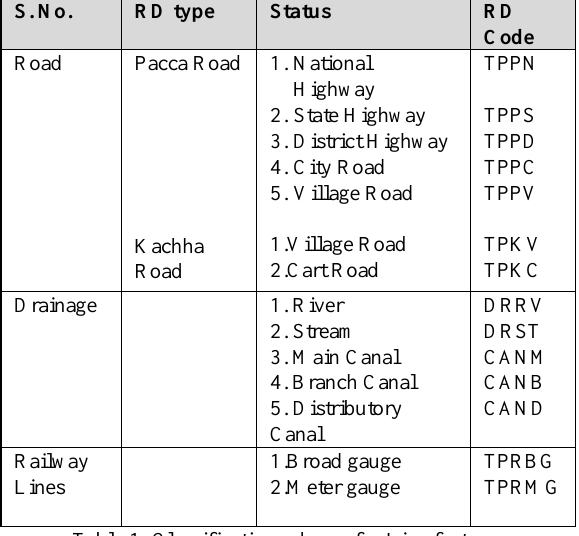
Table 1. Classification schema for Line features The line features (road, canals & drains) were digitized in the center of the features and the length of the strip was fixed with the help of start and end GPS point of the strip. The digitized road strip in- between Agroha to Adampur with line